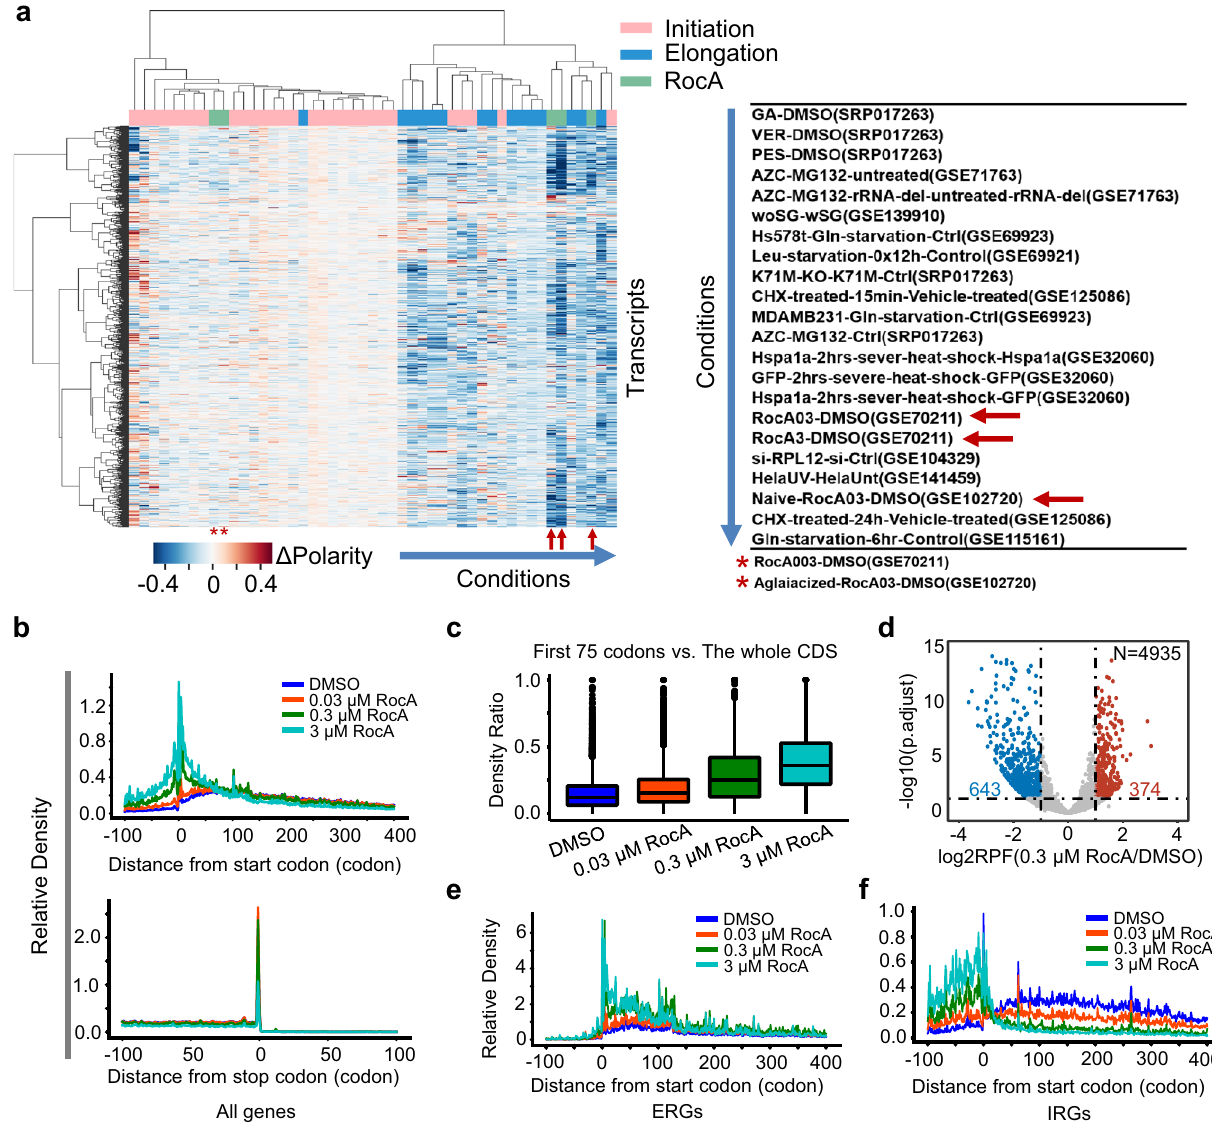
Fig. 1 | Reanalysis of ribosome pro fi ling datasets reveals patterns of ribosome occupancy. a Heatmap (left panel) showing hierarchical clustering of 49 condi- tions of translation perturbation, based on the pro fi les of the polarity differences by comparing the treatment to the control groups. The 49 conditions were arranged by columns, and the 4842 transcripts were arranged by rows. The con- ditions of the second major cluster are listed to the right. The red arrows indicate the three RocA treatment conditions. The red asterisks indicate another two con- ditions of RocA. b Metagene plots of the averaged RPF read densities for all the transcripts (GSE70211). The X-axis represents the distance from the start codon (upper panel) and stop codon(lowerpanel). The transcripts used for the plot were